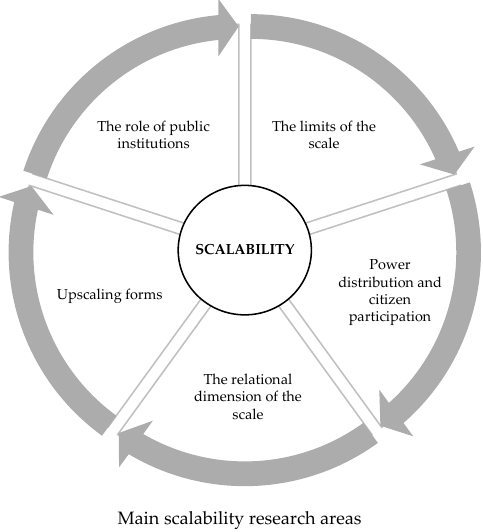
Figure 1. Section organization according to the findings.